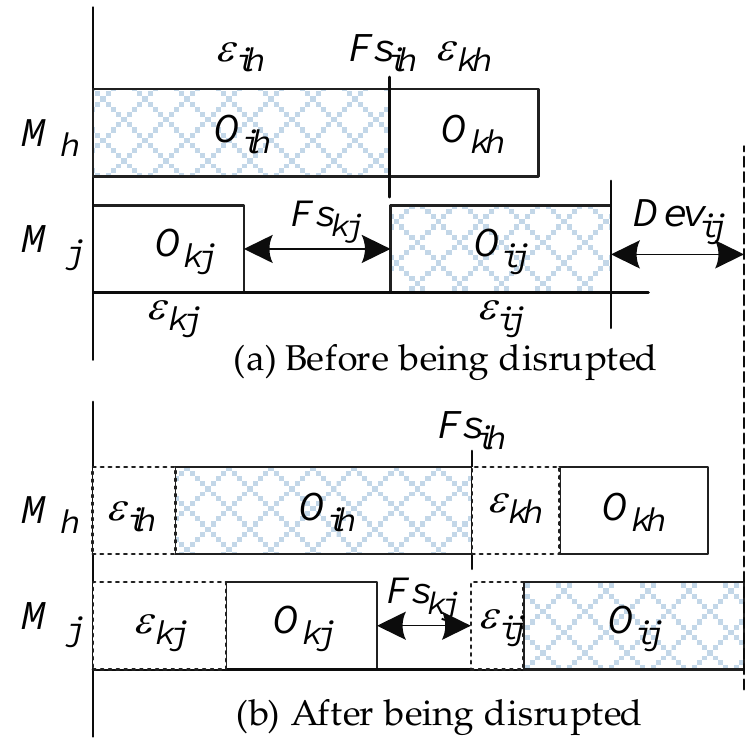
Figure 2. An instance of two consecutive jobs processed on two machines.